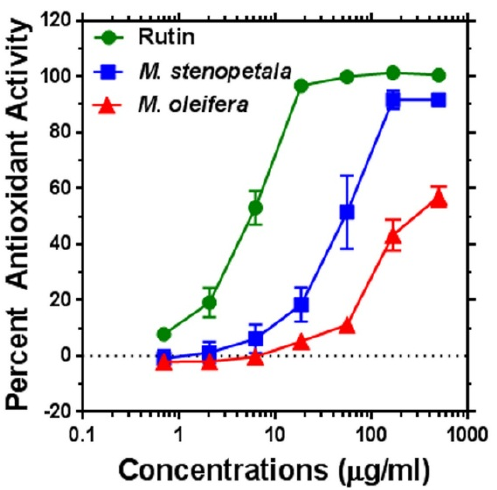
Figure 2. Comparative radical scavenging effect of M. stenopetala, M. oleifera and rutin.